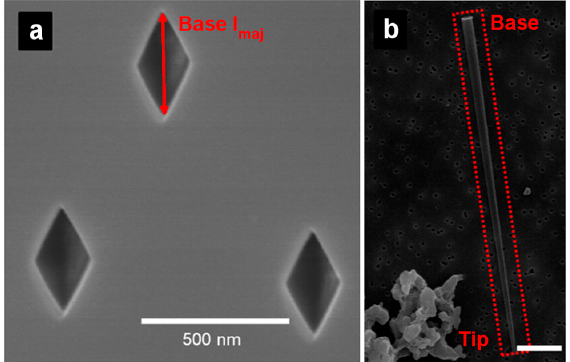
Figure 3. Scanning electron micrographs of ( a ) base openings in a track-etched pyramidal pore mica membrane and ( b ) a carbon replica of a pyramidal pore (scale bar: 3 µm) in the red dashed rectangle. The base major axis length Base l maj is represented. Reproduced with permission from [32]. American Chemical Society,